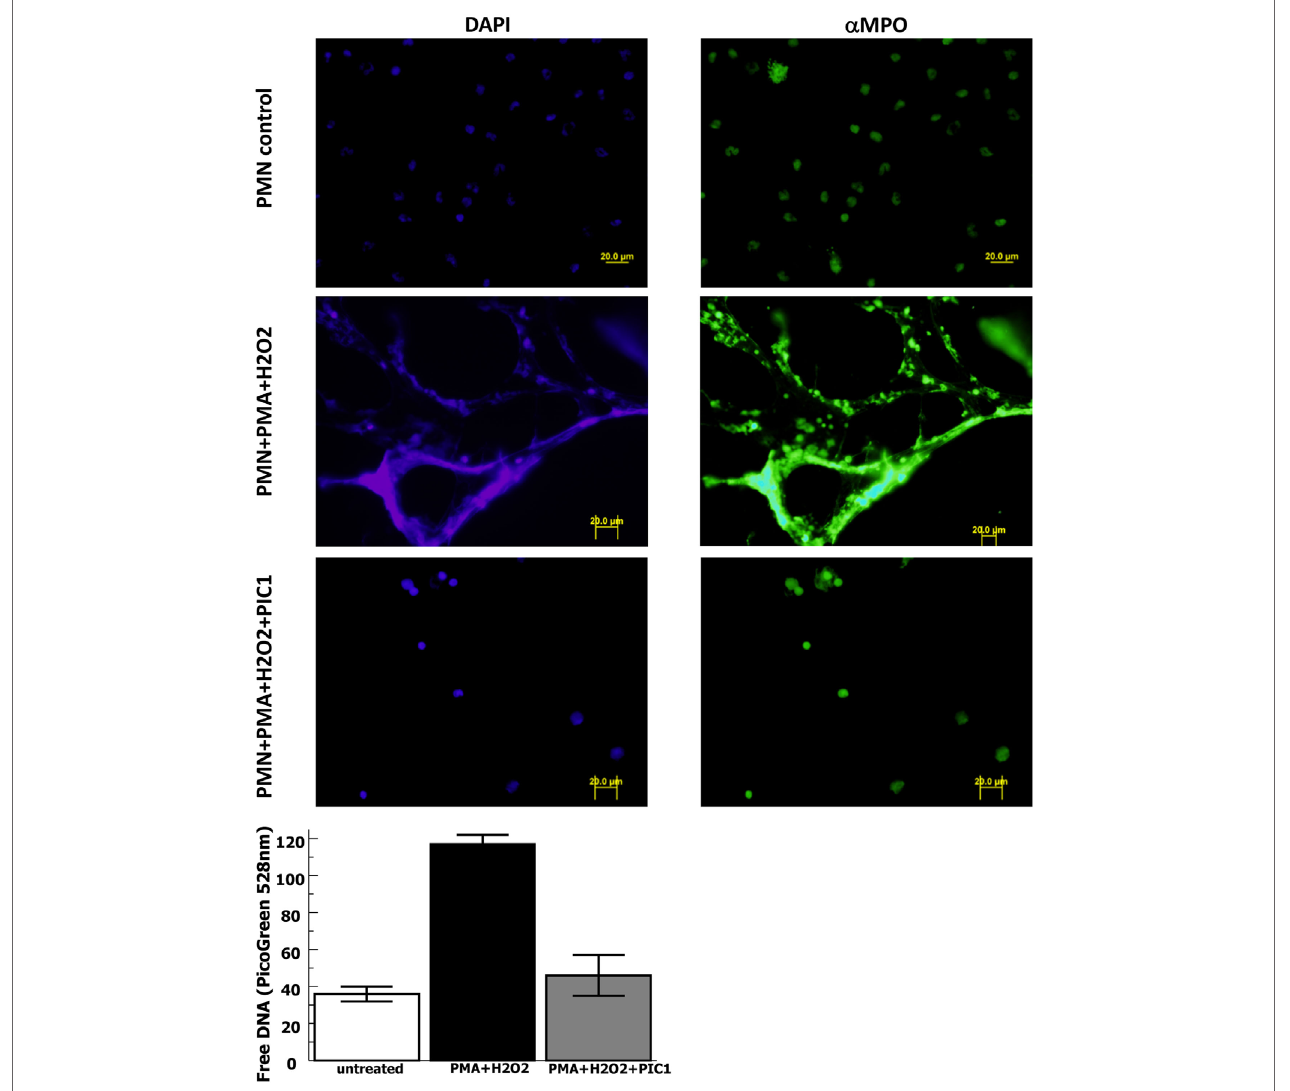
FigUre 4 | PA-dPEG24 inhibition of PMA-initiated neutrophil extracellular trap (NET) formation with human neutrophils (PMN) assayed by fluorescence microscopy and PicoGreen quantitation of free DNA. The first row shows unstimulated neutrophils, the second row shows neutrophils stimulated with PMA and hydrogen peroxide (H 2 O 2 ), and third row shows neutrophils stimulated with PMA + H 2 O 2 in the presence of 5 mM PA-dPEG24 peptide inhibitor of complement C1. The first columns are slides probed with DAPI to visualize DNA and the second column are slides probed with anti-myeloperoxidase antibody. The graph shows PA-dPEG24 (5 mM) inhibition of NET generation by human neutrophils stimulated with PMA + H 2 O 2 assayed by PicoGreen. Data are means of ( n = 3) independent experiments ±